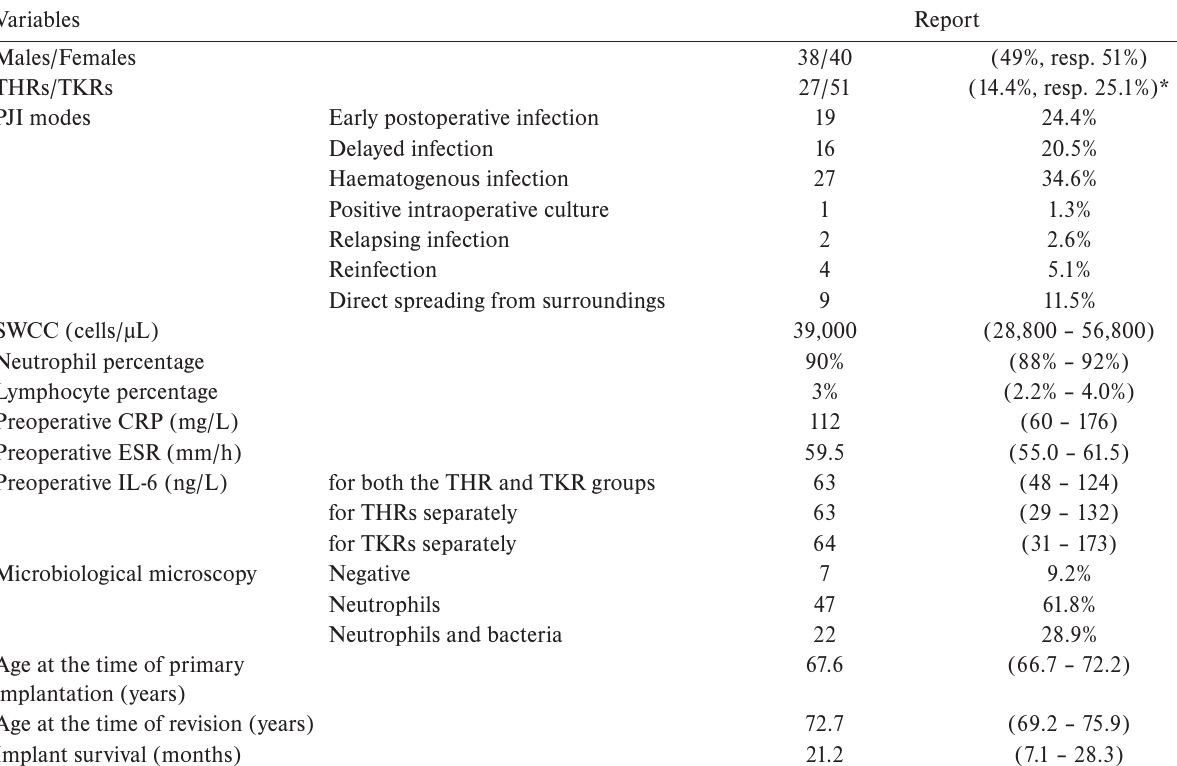
Table 1. Basic characteristics of the group of patients revised due to PJI.